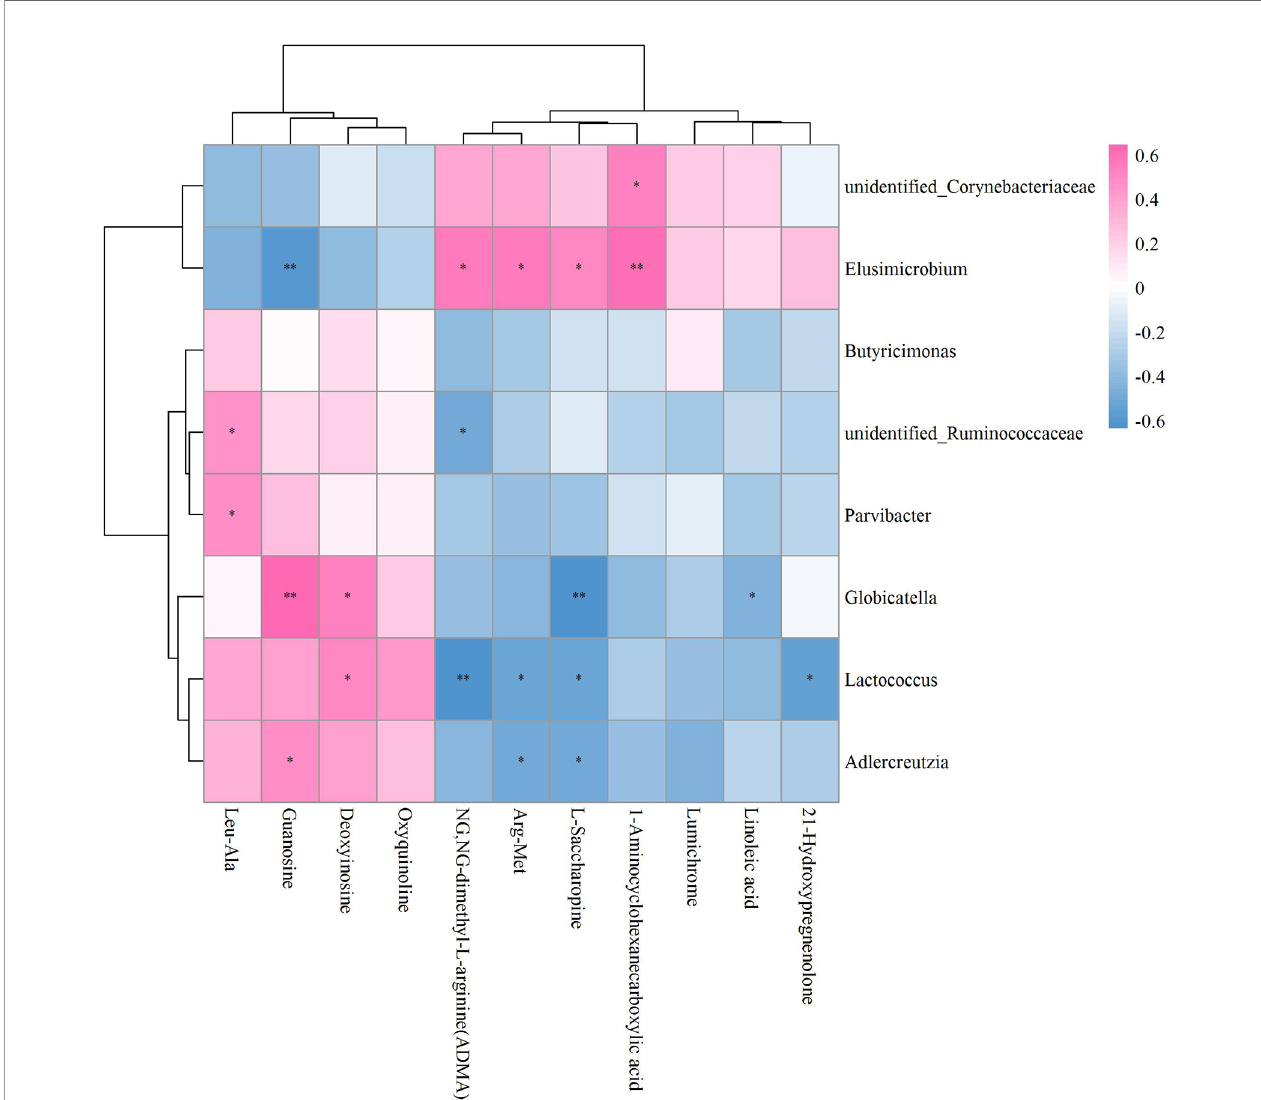
FIGURE 8 | Hierarchical clustering heat map of the signi fi cant differential GM and fecal metabolites in OVX+ICA and OVX groups based on Spearman correlation analysis (n = 10). * and ** mean a signi fi cant correlation between GM and fecal metabolites was found based on p < 0.05 and p < 0.01,